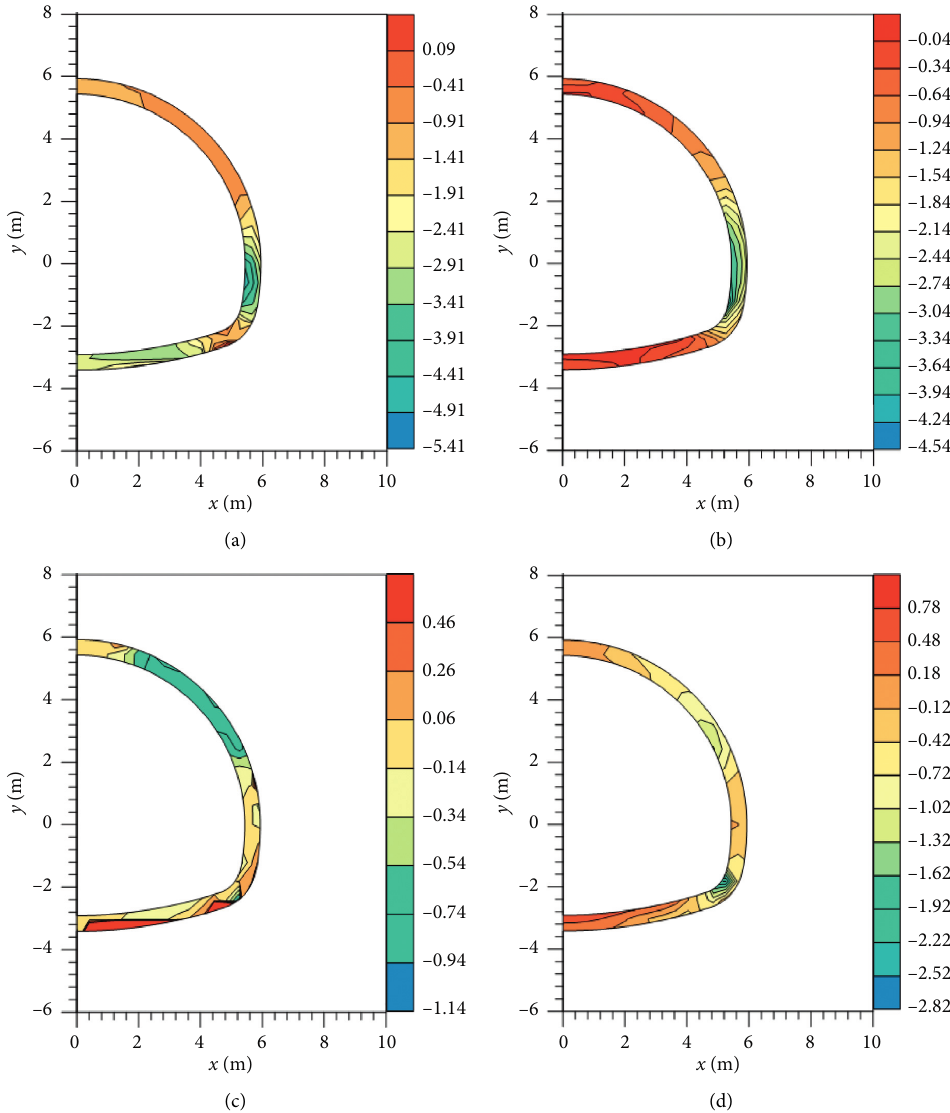
Figure 7: Stress regimes of the second lining structure at D1 in WTIL on April 15 in 5 years of the operation period of the tunnel. (a) MAPS in cold season. (b) MAPS in warm season. (c) MIPS in cold season. (d) MIPS in warm